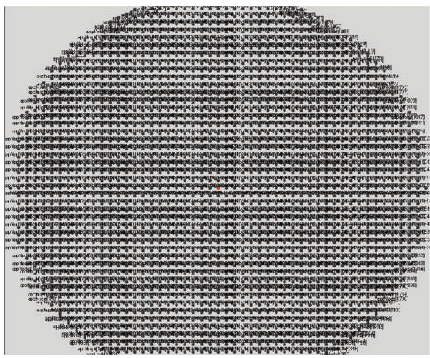
Figure 18: Uniformly deployed network.